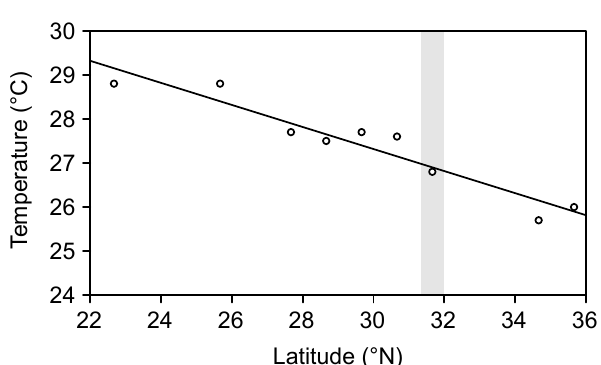
Fig. A1. Temperature as a function of latitude across the BV47 cruise transect (see Fig. 1). Shaded region represents approximate location of BATS. Regression line depicts significant inverse relationship between temperature and latitude (Spearman rank correlation, ρ = − 0.92, P<0.001).